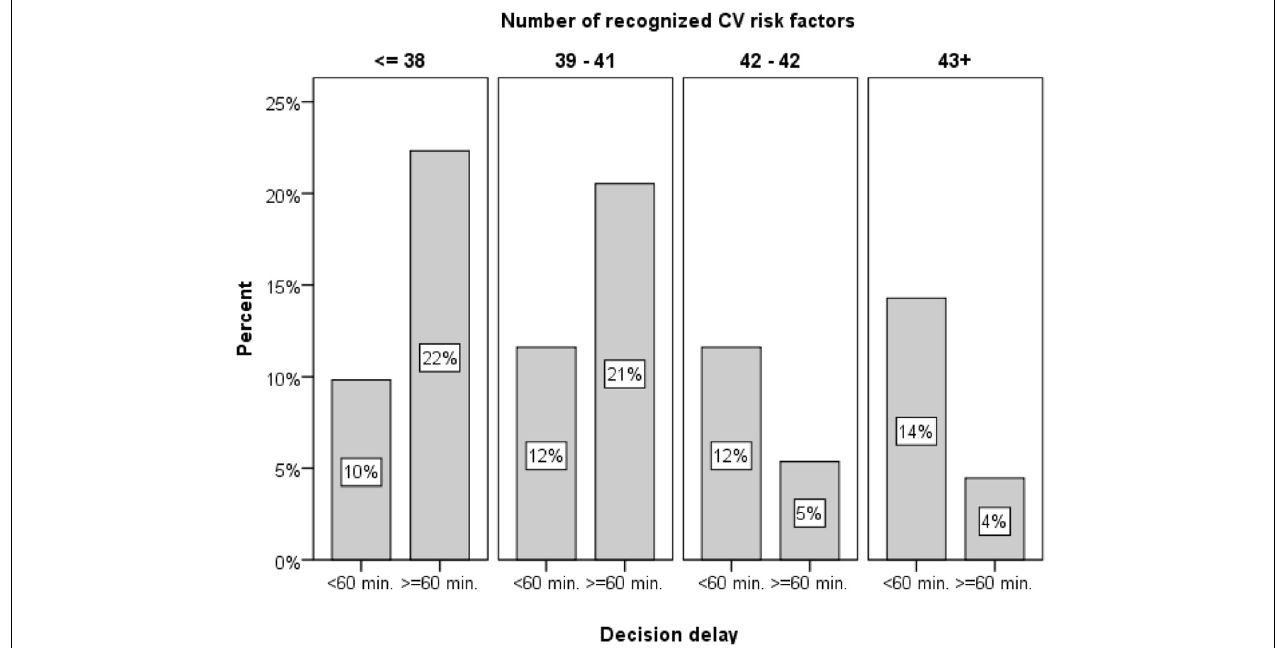
FIGURE 2 | Percentage of patients waiting more than an hour to seek help after symptom onset as a function of cardiovascular symptom knowledge